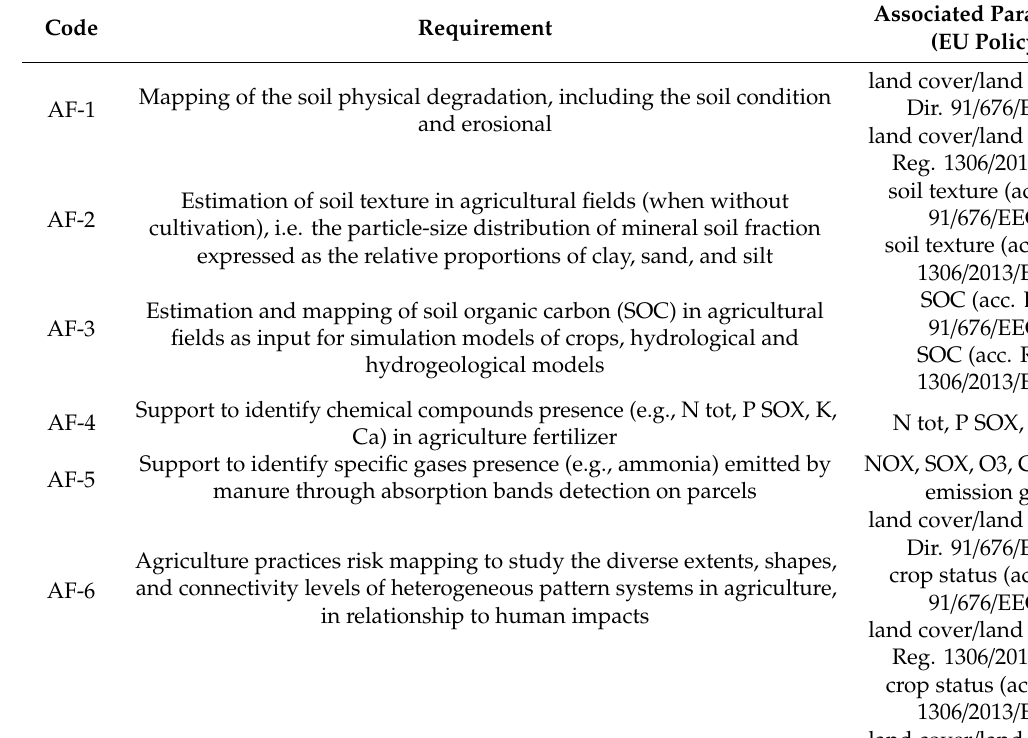
Table A1. Link between the requirements and the associated parameters that were identified for the “AF” thematic area by the interaction with the user communities. Each requirement is labeled with a unique code, not representing any ranking or order in any